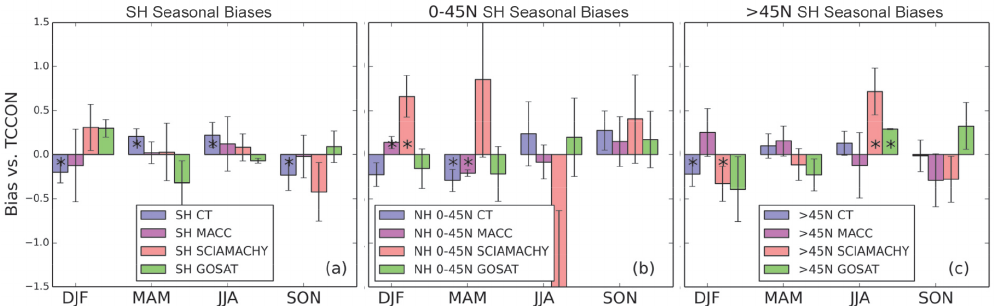
Figure 8. Bias for 3-month groups for Southern Hemisphere (left panel), 0–45 ◦ N (middle panel), and poleward of 45 ◦ N (right panel). Each station composing each group is normalized to have zero average over the year. The Southern Hemisphere (left panel, Lauder (except SCIAMACHY), Wollongong, and Darwin) has relatively small biases. 0–45 ◦ N includes Tsukuba and Lamont. >45 ◦ N includes Karlsruhe, Park Falls, and Orléans for satellites, and those plus Sodankylä and Bialystok for models. The results that are significant according to the t test are shown with a * in the bar